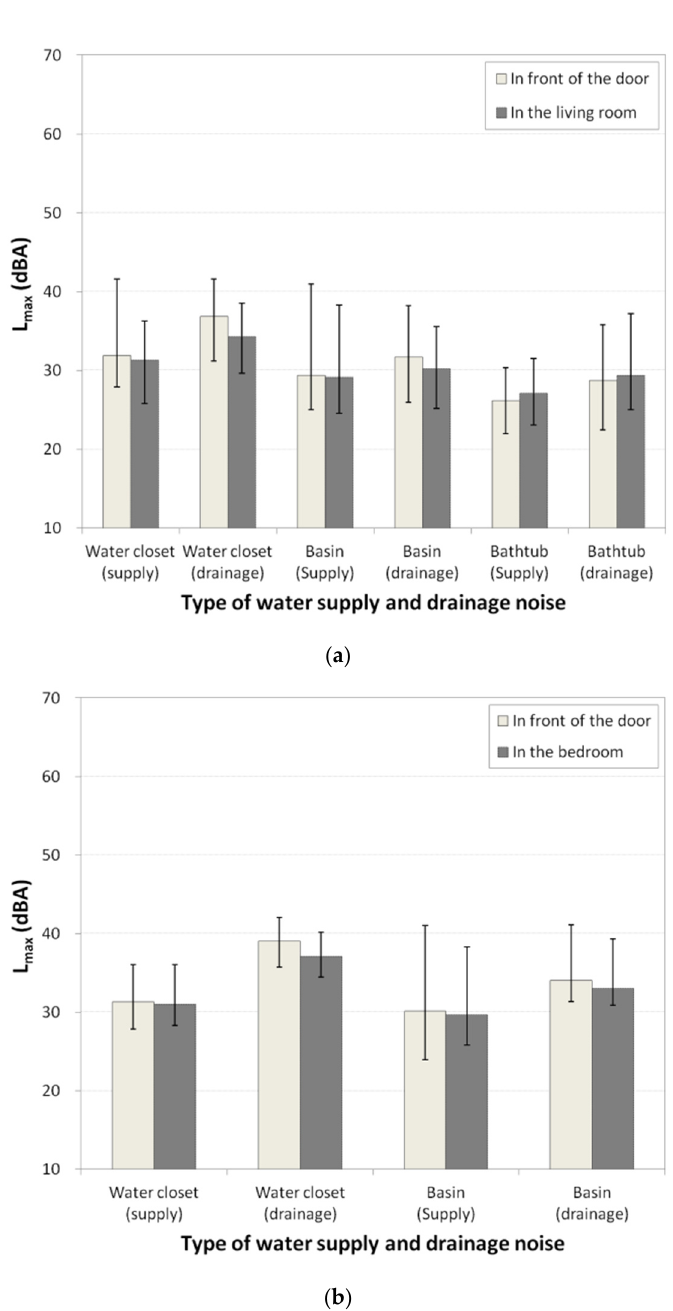
Figure 13. Noise levels measured in the living room ( N = 11) and bedroom ( N = 8) according to the different operational conditions of each sanitary ware in 11 different floor plans: ( a ) living room; ( b ) bedroom.